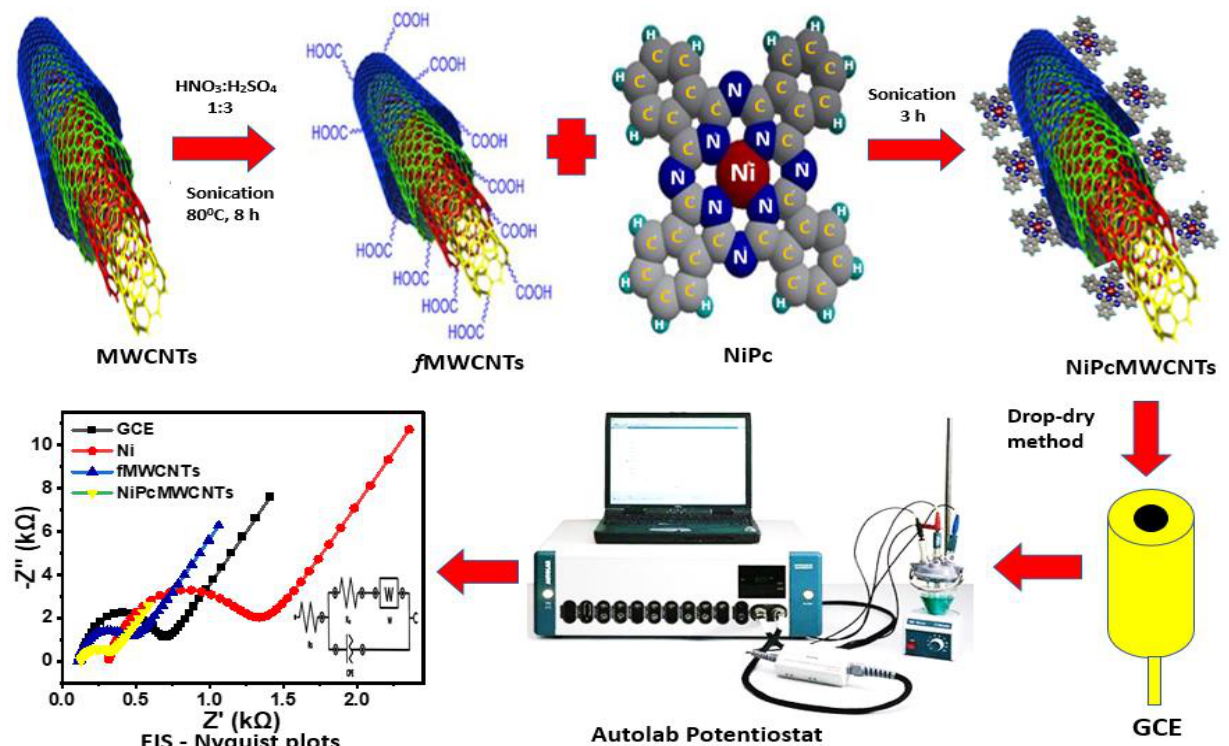
Figure 1. Schematic diagram for the fabrication, modification, and EIS characterization of GCE-NiPcMWCNTs-modified electrode.